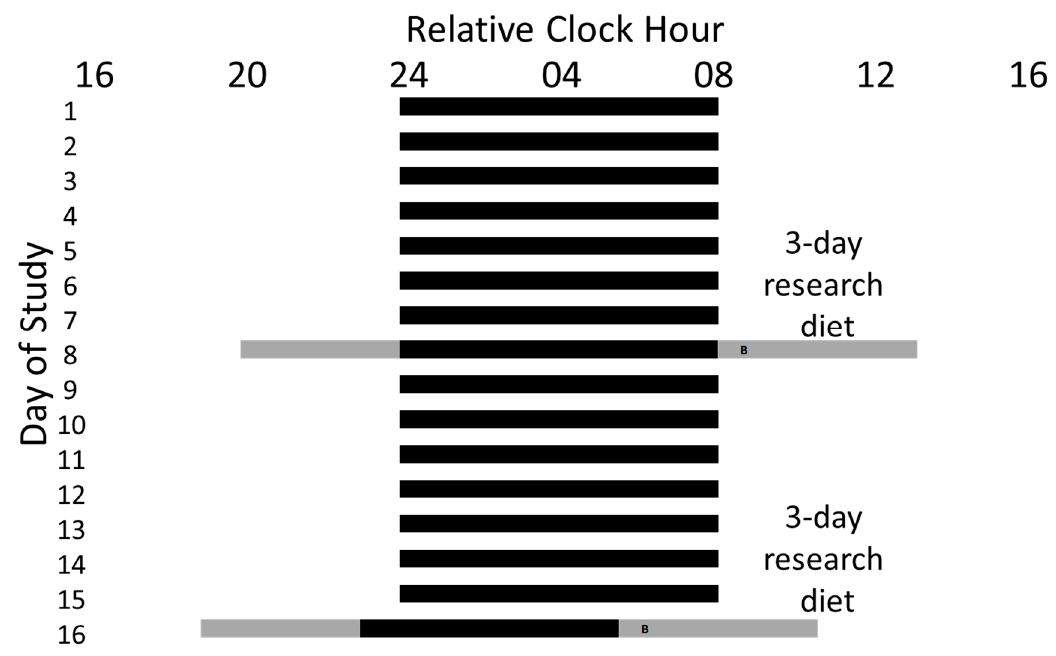
Figure 1. Example Study Protocol. A 16 day study protocol for a participant with a habitual